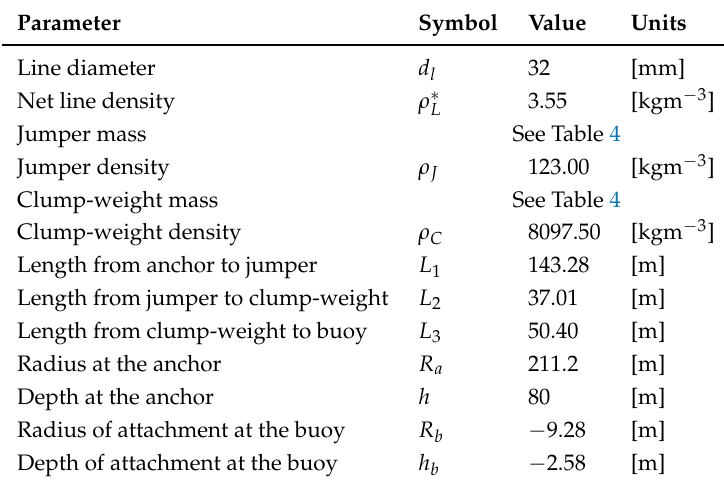
Table 3. Parameters of the full-scale mooring system, based on the experimental tests in